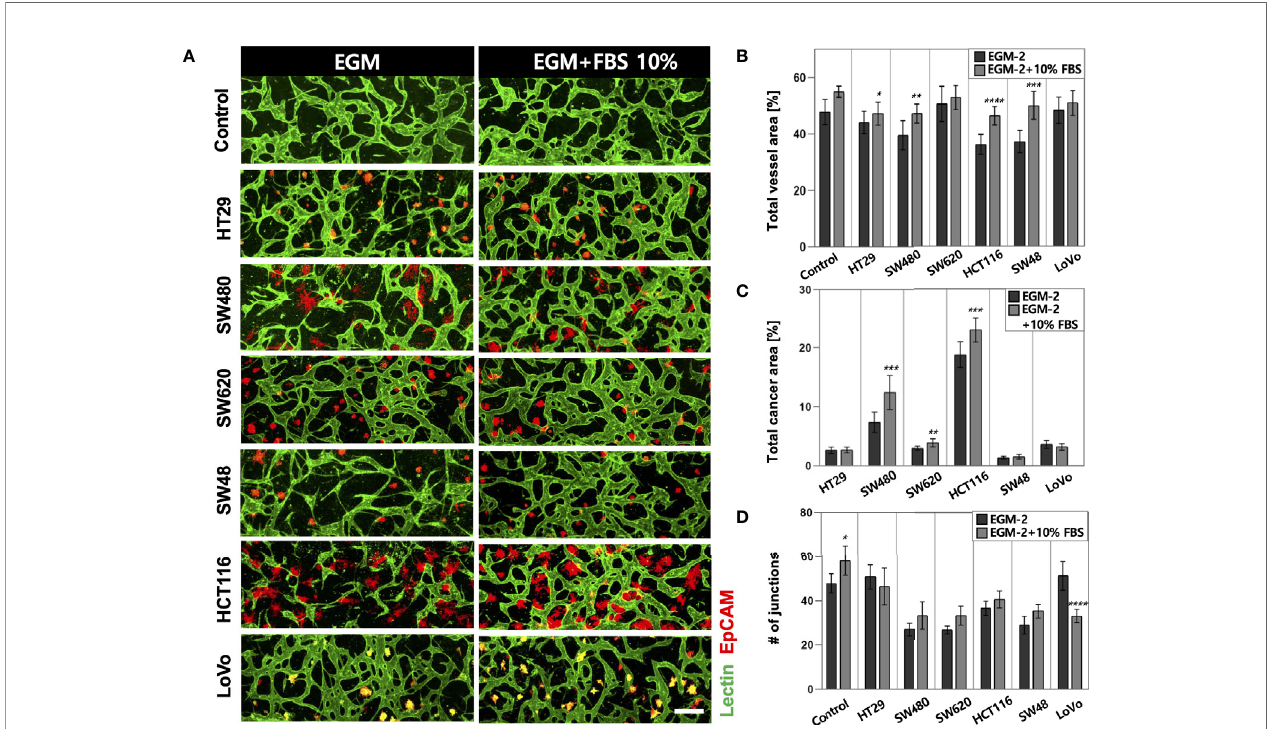
FIGURE 2 | Optimization of the culture condition for the formation of perfusable blood vessels co-cultured with CRC cells. (A) Confocal images of blood vessels (lectin, green) with various types of CRC cells (EpCAM, red) in EGM-2 or EGM-2 supplemented with 10% FBS medium. (B) Plot of total vessel area for different CRC cell lines. Total vessel area increased when 10% FBS was added to the culture medium. (C) Plot of total cancer cell area for various CRC cell lines. The cancer area was signi fi cantly increased in some CRC cell lines (SW480, SW620, and HCT116) in EGM-2 supplemented with 10% FBS. (D) Plot of the number of junctions in the vascular network. The junction numbers are mostly higher in EGM-2 supplemented with 10% FBS except for the vessels co-cultured with HT29 and LoVo (n = 14 for each cancer cell line). *p < 0.1; **p < 0.01; ***p < 0.001; ****p < 0.0001. Scale bar =